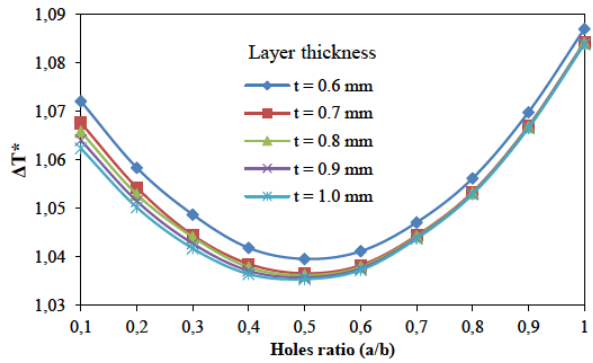
Figure 9: Effect of hole ratio (a/b) on the thermal buckling amplifica- tion factor ( φ = 45 ∘